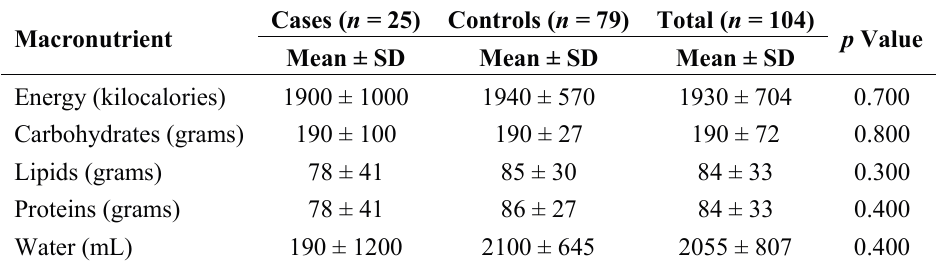
Table 2. Macronutrient intake in subjects with and without psoriasis.